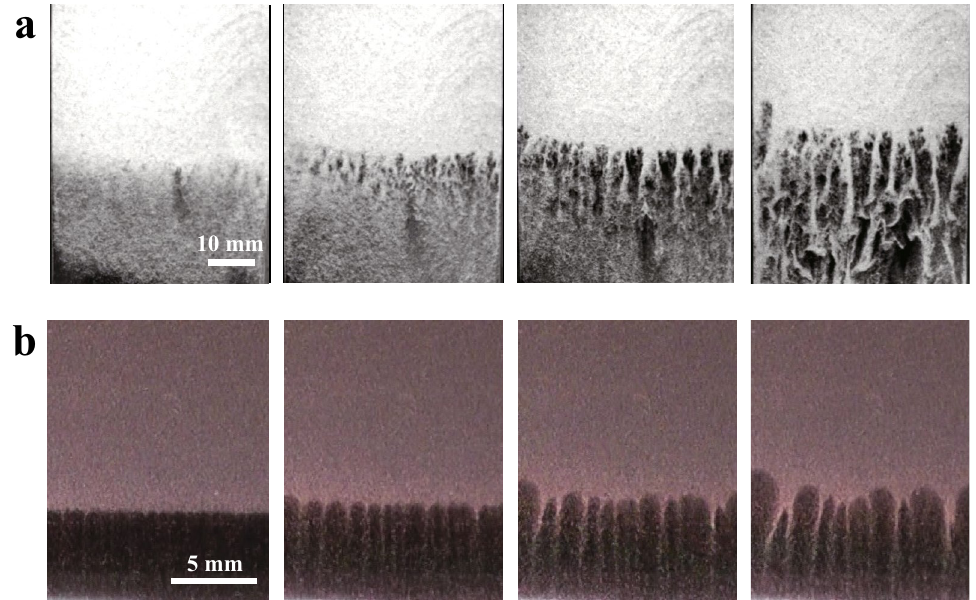
Figure 3. ( a ) Time evolution of the gravitational instability in the granular system. From left to right, t = 0.06 s, 0.1 s, 0.14 s, and 0.24 s. ( b ) Time evolution of the gravitational instability in a physical gel. From left to right, t = 250 s, 350 s, 425 s, and 450 s. The concentration of the gelatin solution is 6 wt% for the upper layer and 5 wt% for the bottom layer. The base temperature is set to 26 °C. The fingering pattern and growth process in the granular system is qualitatively similar to that in the physical gel system.